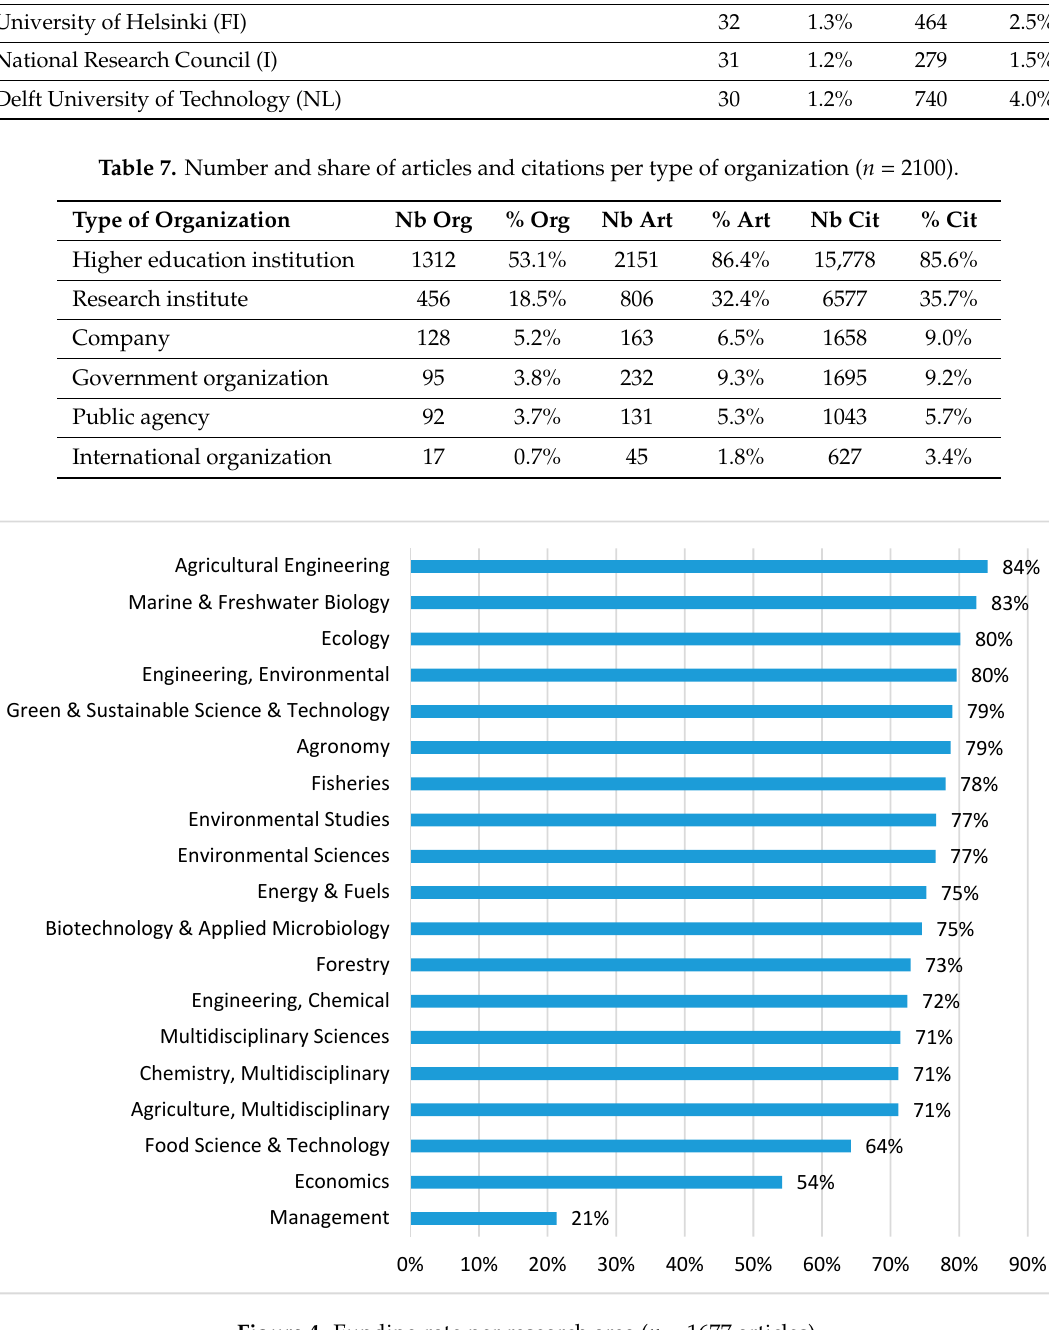
Table 7. Number and share of articles and citations per type of organization ( n = 2100).